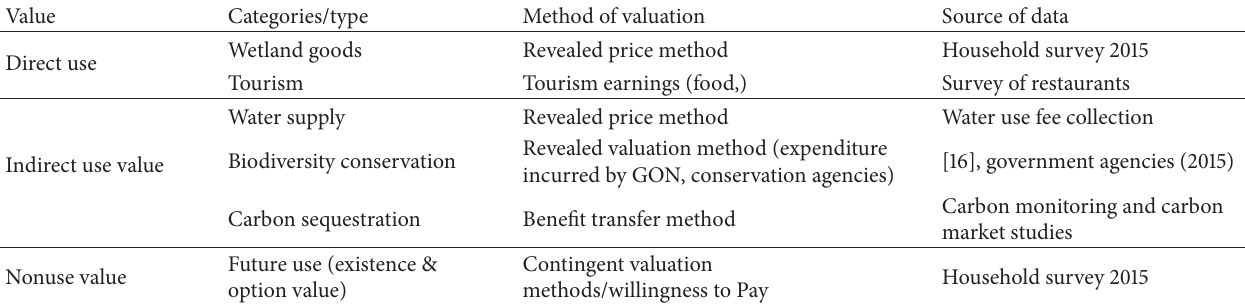
Table 2: Types of use and nonuse value of reservoir and methods of